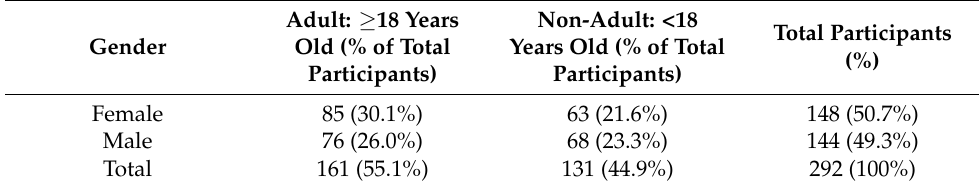
Table 3. Age group and gender of the interviewees who were interviewed for their experience about heat-related complaints and mitigation